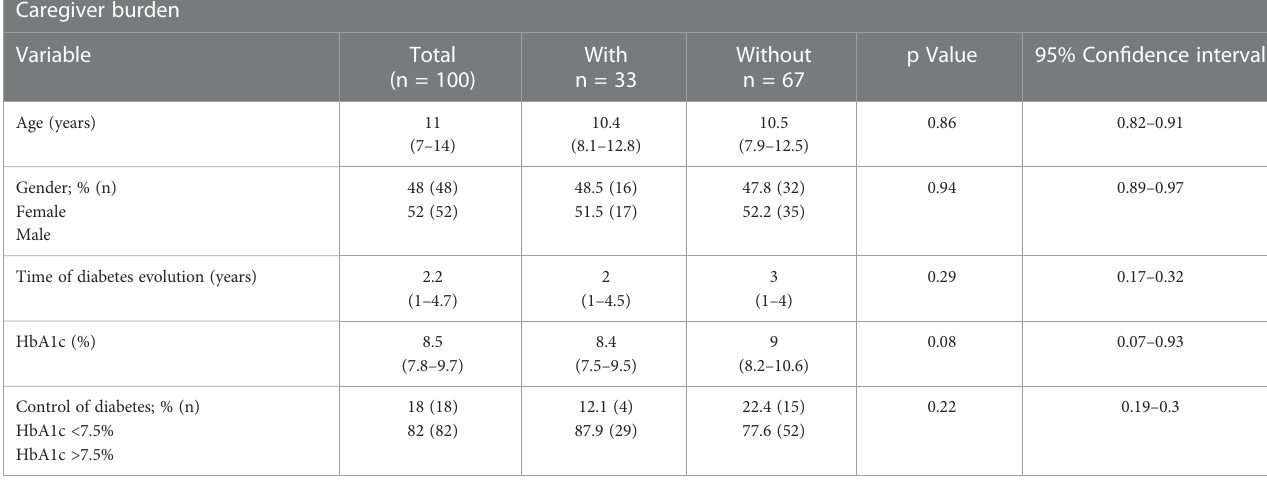
TABLE 1 Characteristics of children and adolescents with type 1 and differences according to the presence of burden in their primary informal caregivers. Caregiver